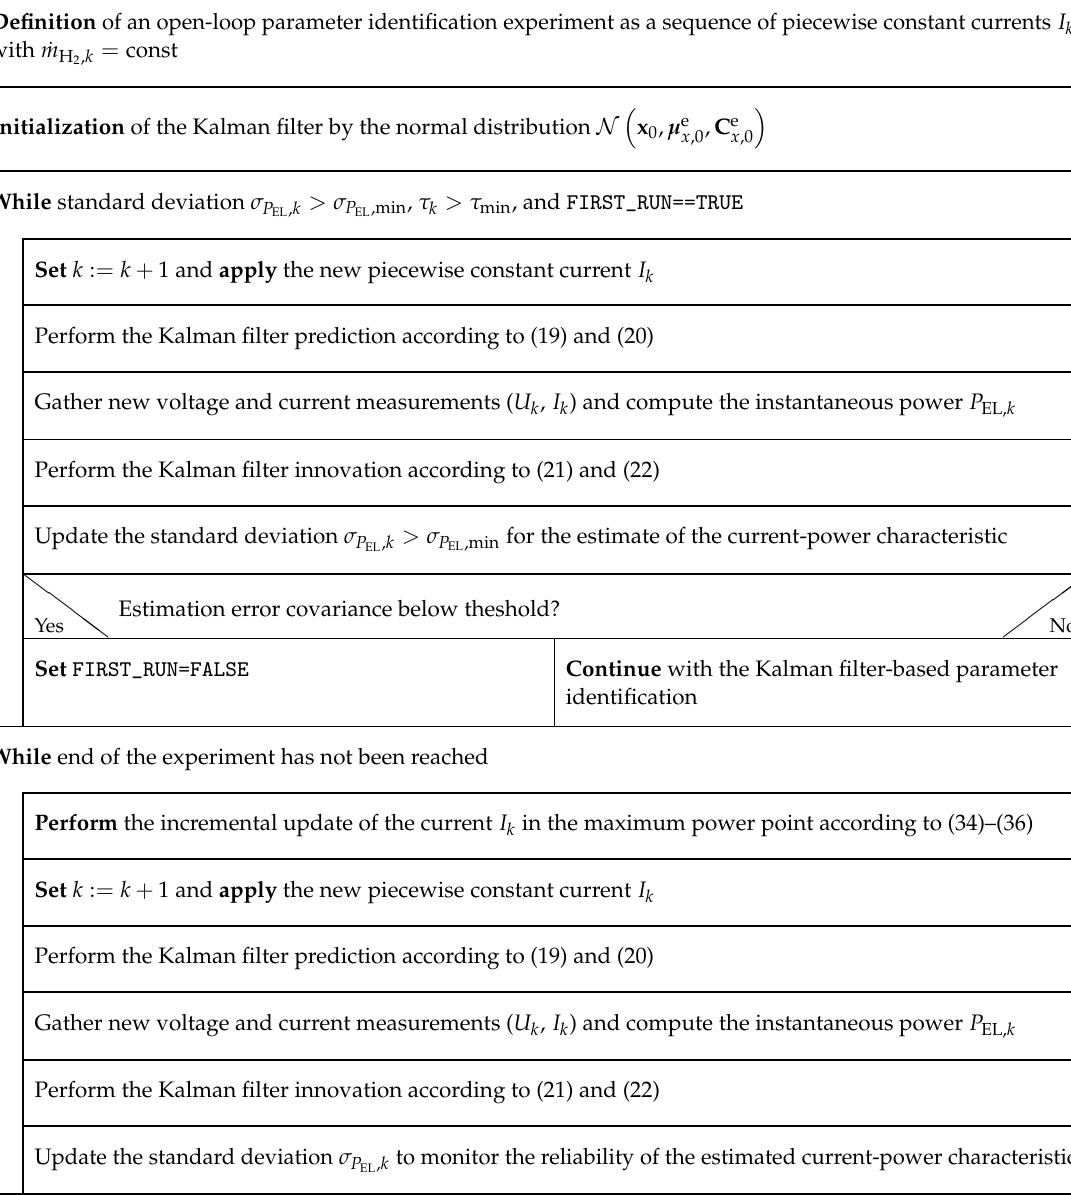
Figure 7. Structure diagram of the Kalman filter-based parameter identification and maximum power point